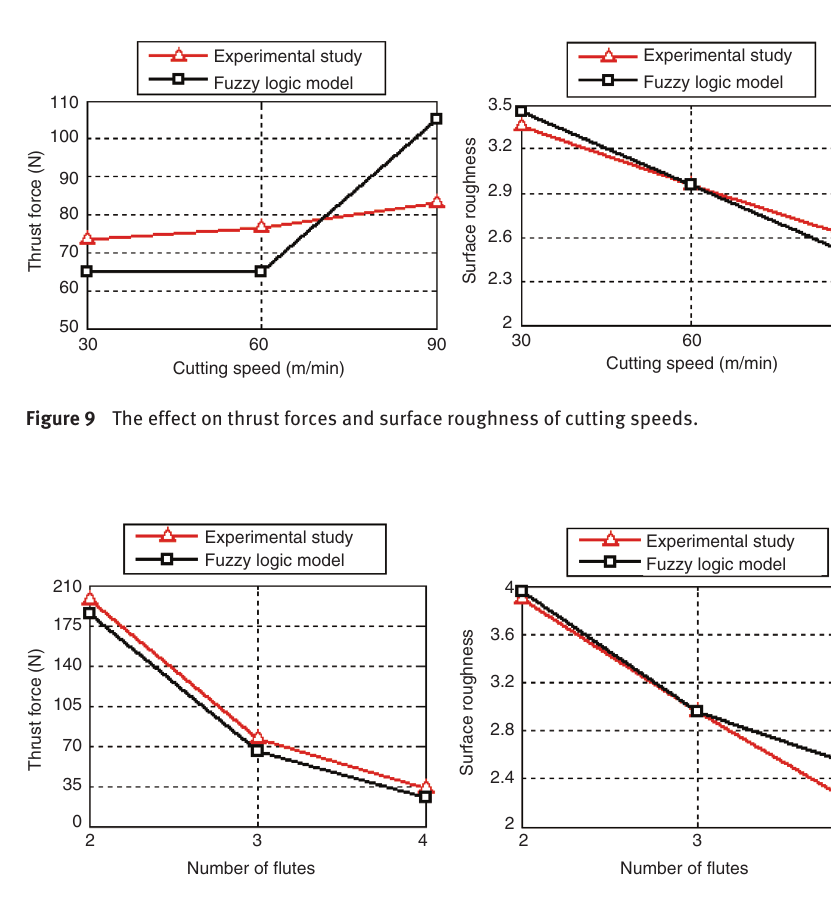
Figure 10 The effect on thrust forces and surface roughness of number of flutes.